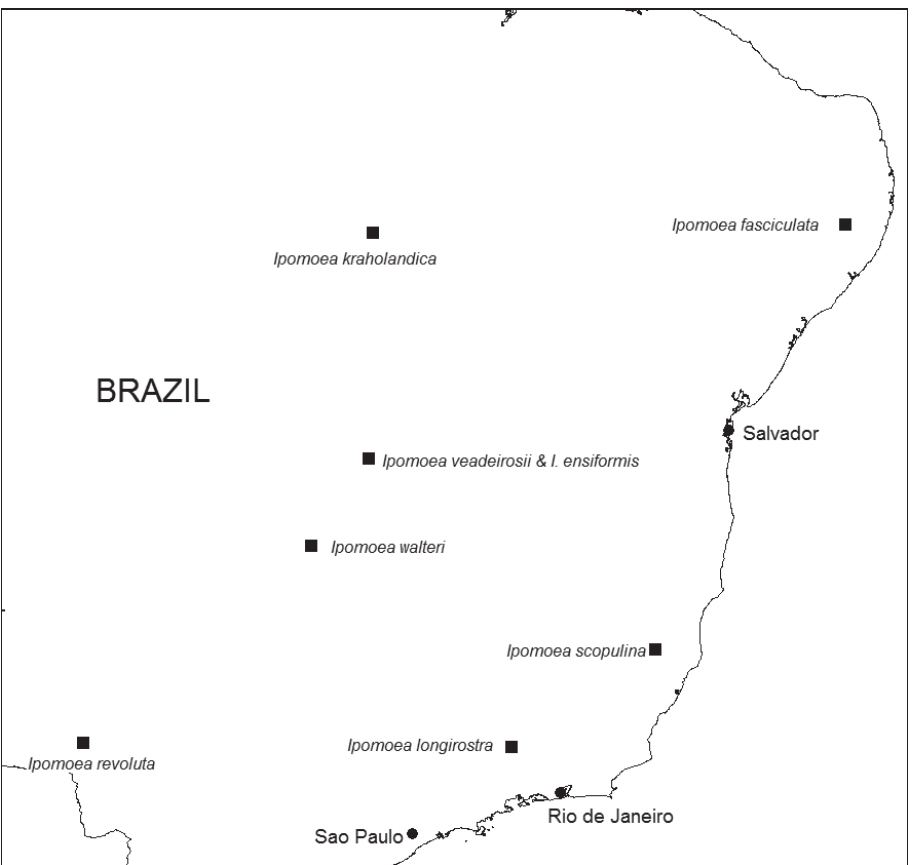
Figure 9. Map of Eastern Brazil showing distribution of I. ensiformis , I. fasciculata , I. kraholandica , I. longirostra , I. revoluta , I. scopulina , I. veadeirosii, and I. walteri